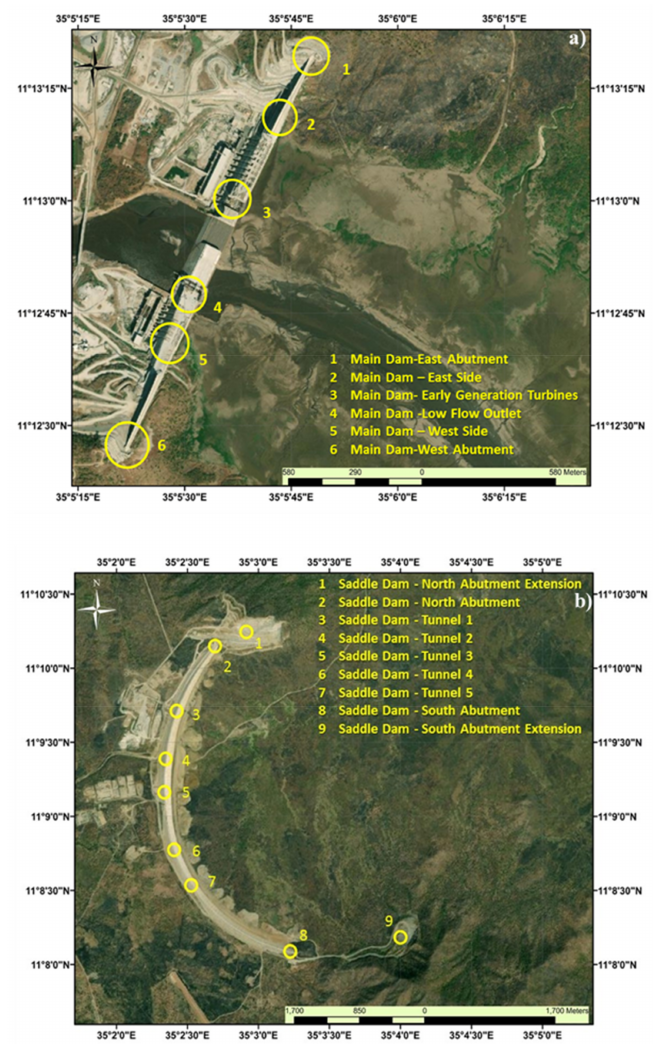
Figure 4. A base map showing the cross-sections where the vertical displacements are calculated and presented for the GERD’s ( a ) Main Dam and ( b ) Saddle